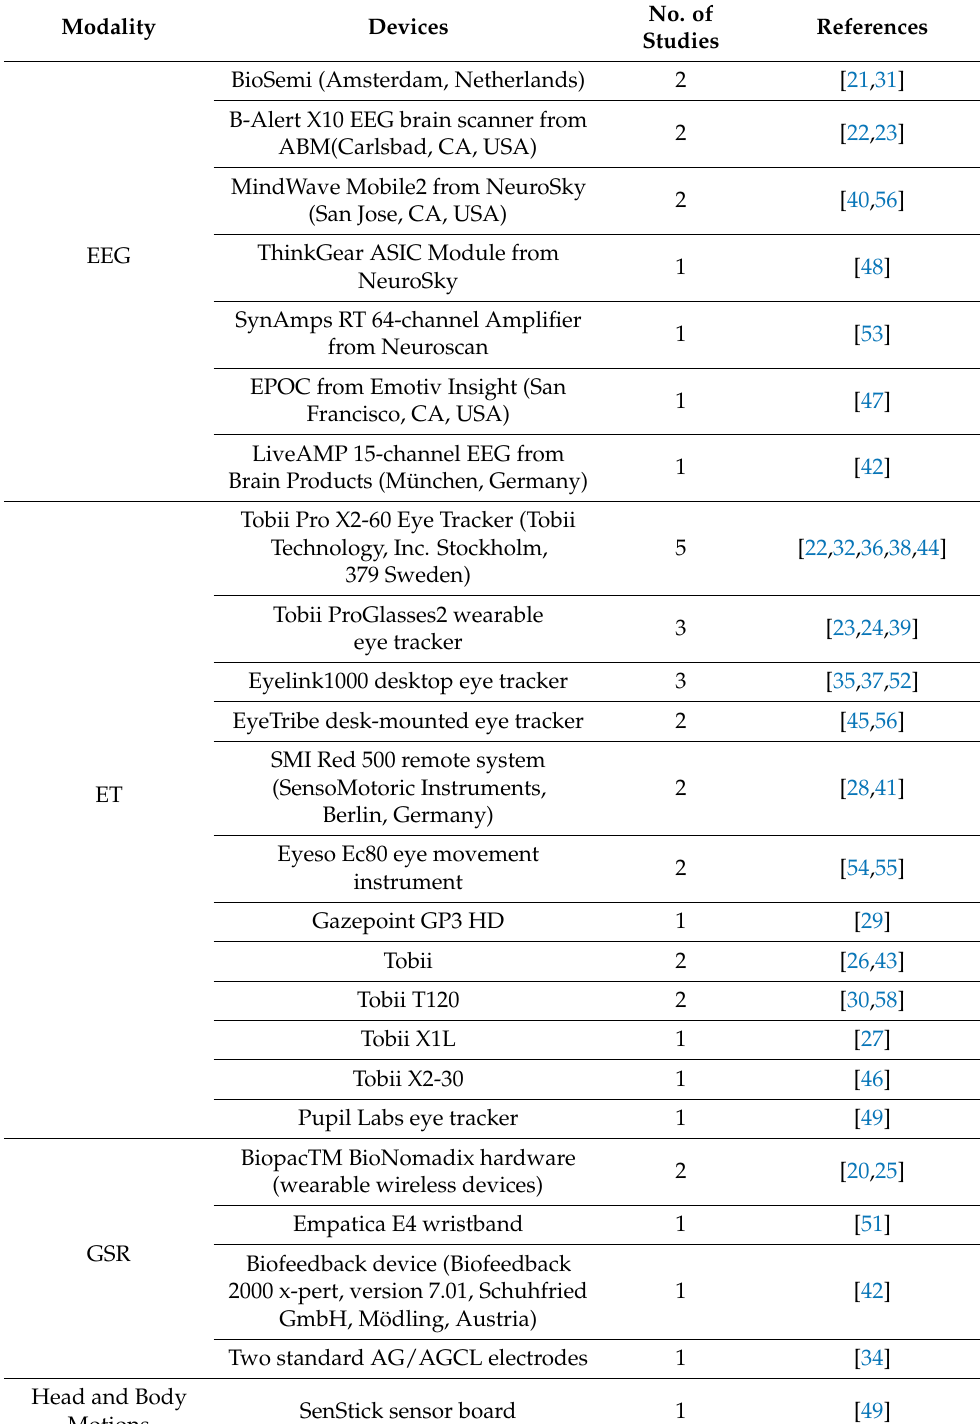
Table 6. Hardware devices used in neuro-tourism